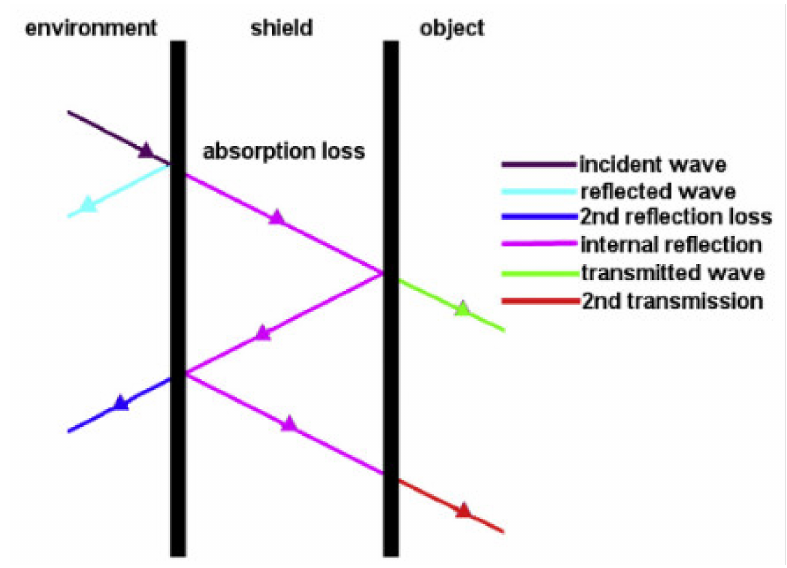
Figure 6. The operation of an EMI shielding material [192]. Copyright Elsevier